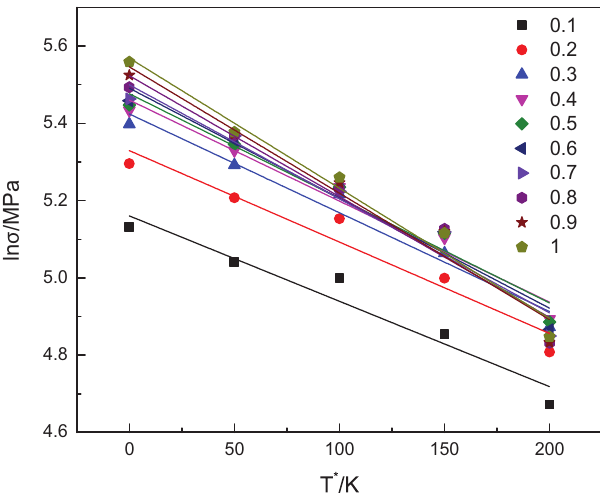
Figure 11: The relationship between ln σ and T * at the reference strain rate.